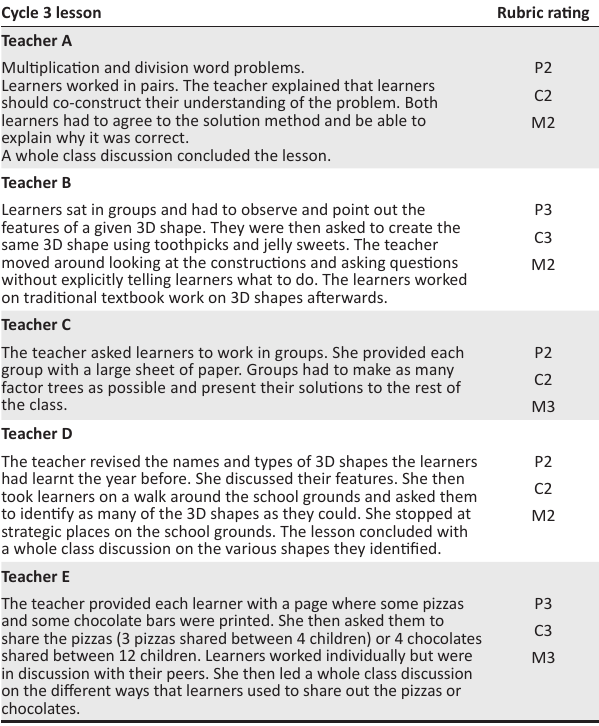
TABLE 3: Summary of Cycle 3